Question: What kind of plot is shown here?
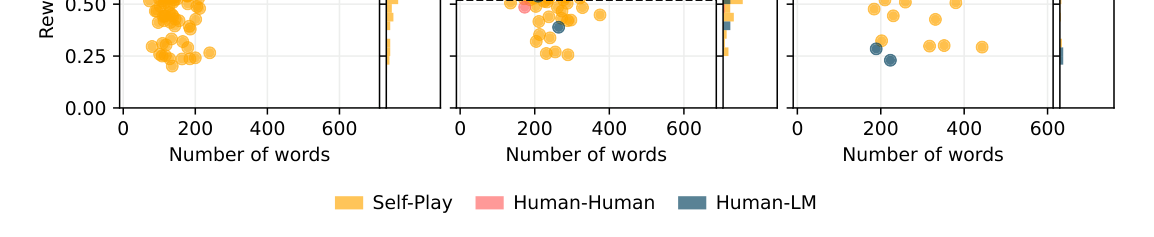
Answer: histogram